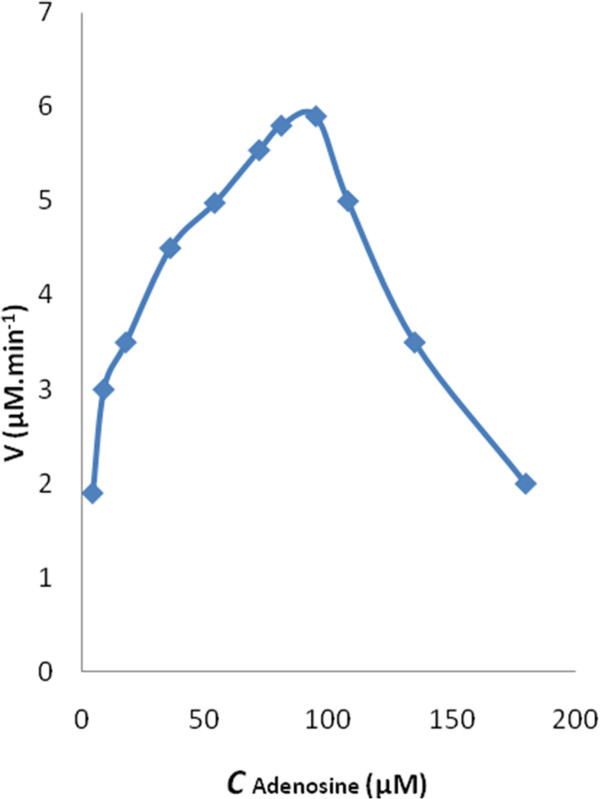
A Michaelis–Menten plot was used to determine Km and Vmax. The calculated Km was 37.6 μM and Vmax was 15.7 μM min-1 (n = 3).